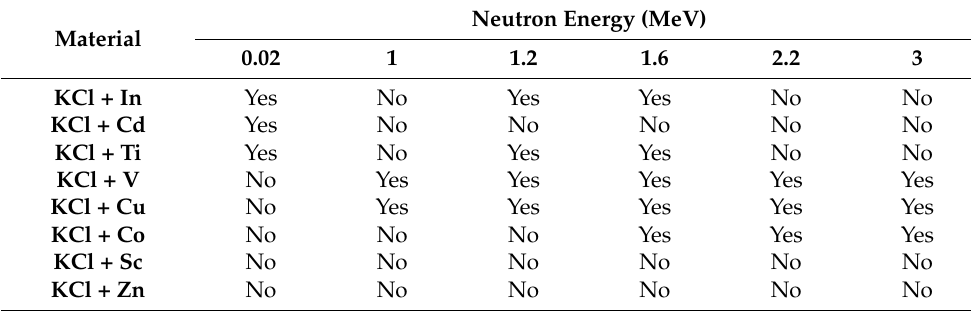
Table 2. Gamma ray response of each material versus initial neutron energy.